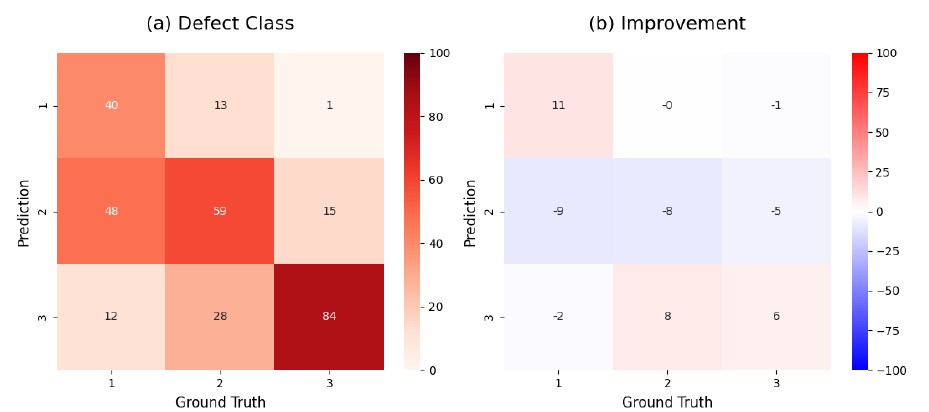
Figure 14. ( a ) Confusion matrix for the severity estimation task of the multi-branch model. ( b ) Ac- curacy improvement of the multi-branch model compared to the single-task model (severity) from Figure 9. The model shows both a decrease and increase in accuracy for different classes. However, the overall performance of the task increased, as shown in Table